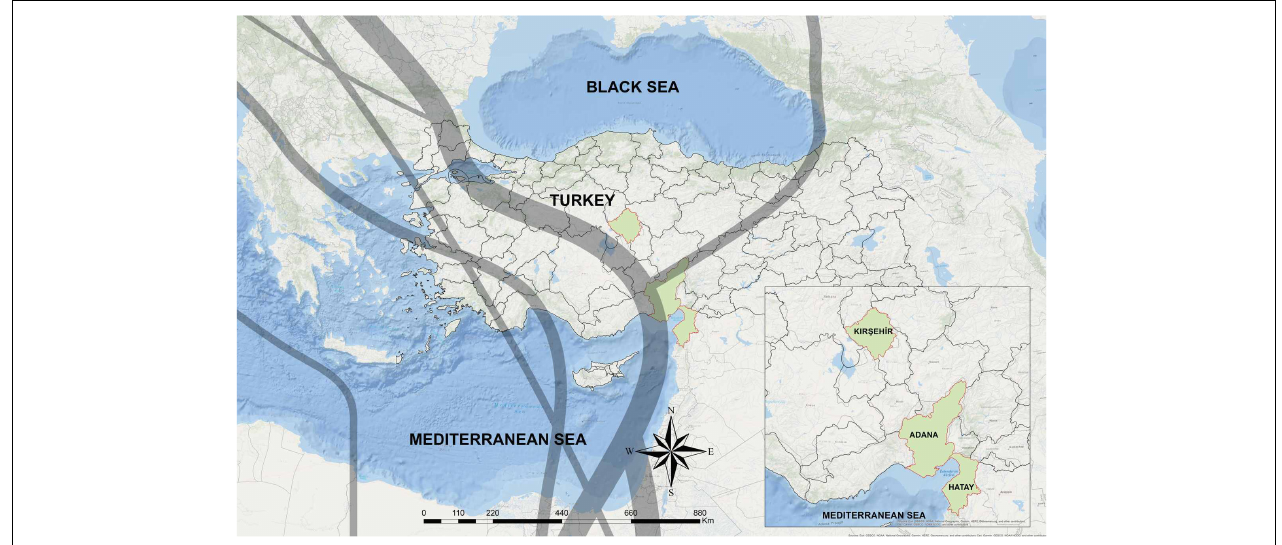
FIGURE 1 | The geographic location of sampling sites in Turkey. The sampling areas are shown in green. Gray lines indicate two main bird migration routes on Turkey, adapted from Özkazanç and Özay